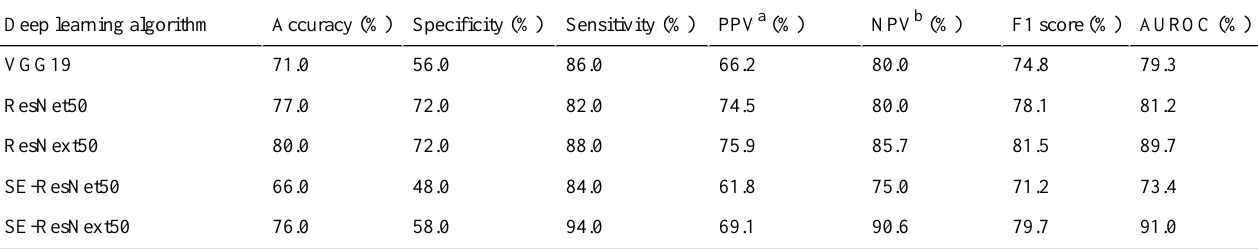
Table 5. Thyroid classification results with conventional deep learning using pooled external test